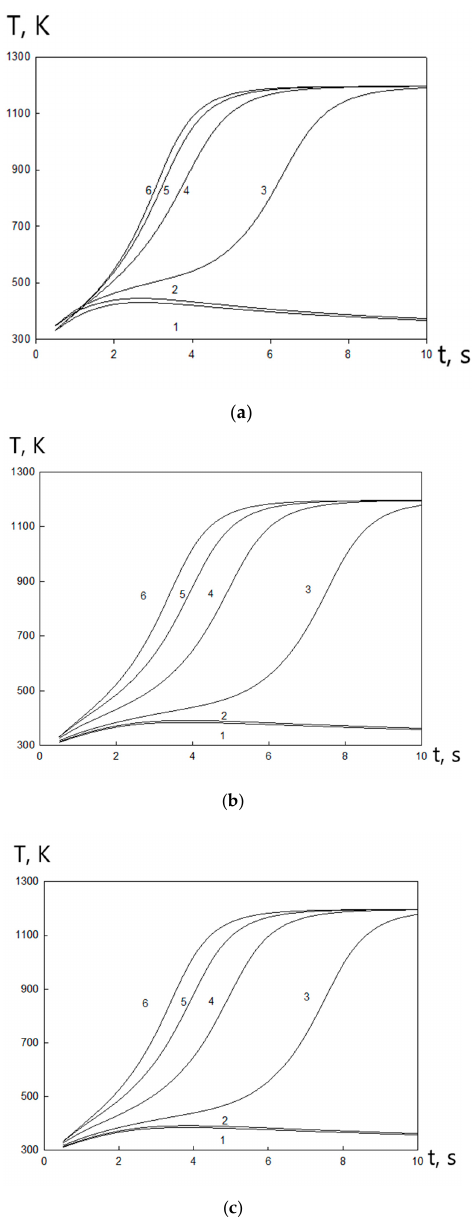
Figure 10. Temperature as a function of time: ( а ) point A, ( b ) point B, ( c ) point C, 𝐷 = 12 mm, 𝐻 = 5 mm, 1 – 𝐿 = 16 mm, 2 – 𝐿 = 18 mm, 3 – 𝐿 = 20 mm, 4 – 𝐿 = 30 mm, 5 – 𝐿 = 40 mm, 6 – 𝐿 = 50 mm.